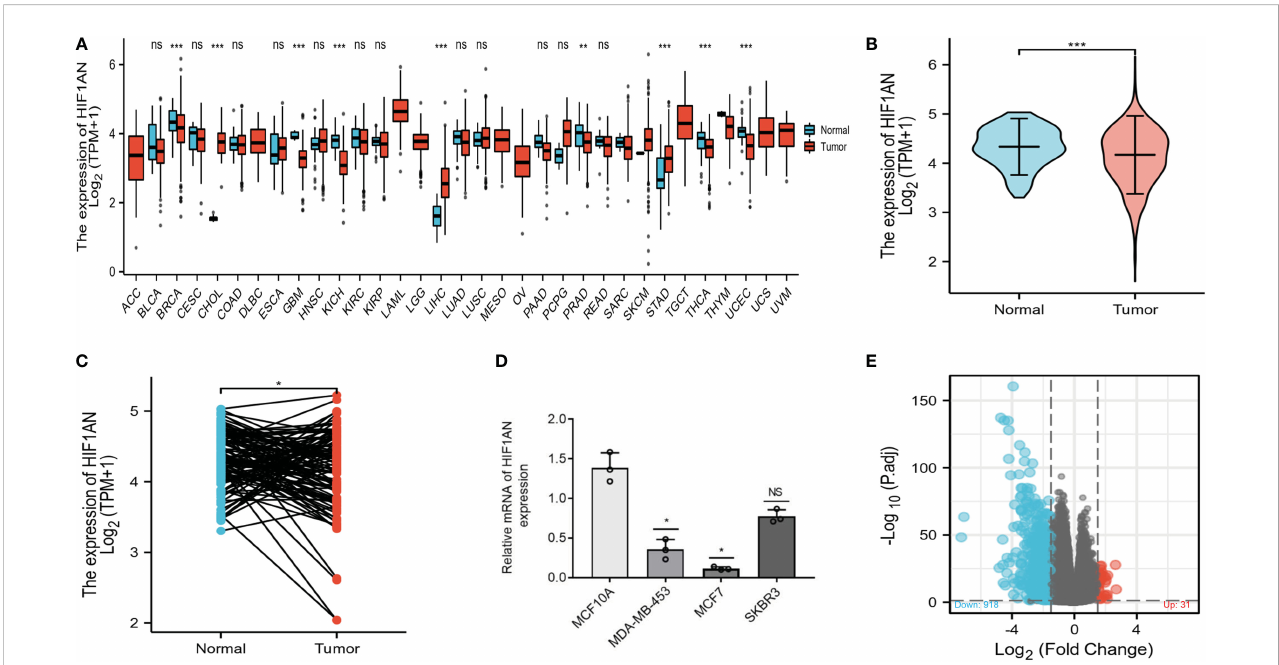
FIGURE 1 Strati fi ed by HIF1AN levels, different mRNA expression patterns in BC patients. (A) The TCGA database-based expression of HIF1AN in various kinds of cancer. (B) According to the TCGA-BRCA data, HIF1AN expression was markedly reduced in BC cells as compared to healthy cells. (C) According to the TCGA-BRCA sets of data, HIF1AN expression was considerably reduced in associated BC tumour tissues as compared to neighbouring healthy tissue. ns, P ≥ 0.05; *P < 0.05; **P < 0.01; ***P < 0.001. (D) Evaluation of HIF1AN mRNA expression levels in breast tissues epithelium and breast cancer cell lines using reverse transcription-quantitative PCR. Mann Whitney U analysis of the relationship between TCGA BRCA datasets ’ HIF1AN gene expression; (E) High- and low-HIF1AN expression cohorts ’ mRNA expression patterns are displayed. Volcano graphs are used to visualize